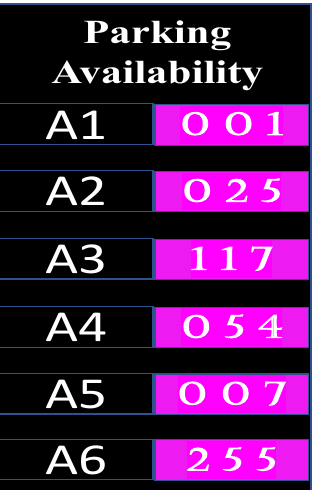
Figure 3. A display screen placed in a smart parking lot, showing parking